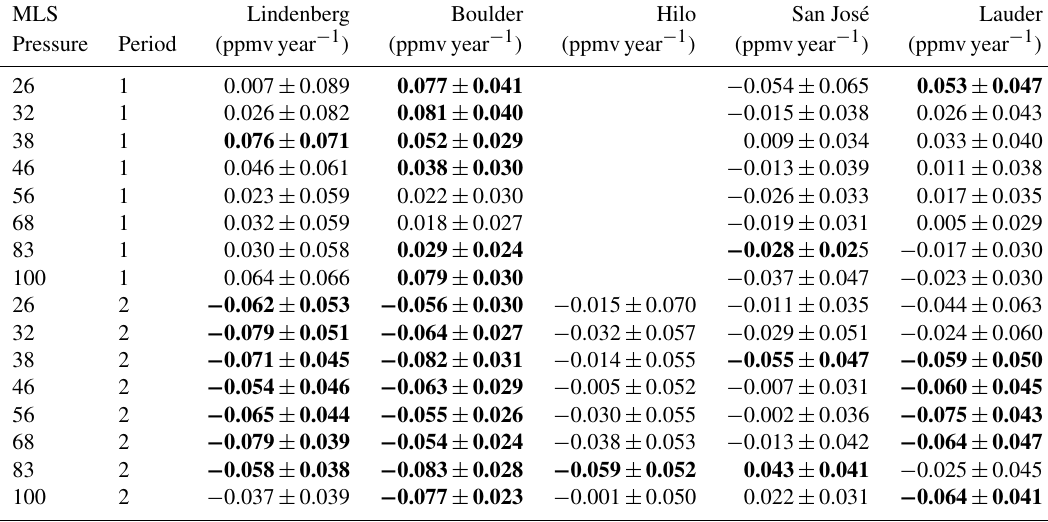
Table 5. Linear regression slopes of FP–MLS v4.2 differences. Slopes are presented with their 95% confidence intervals. Periods 1 and 2 refer to the intervals before and including the changepoint (Table 4) and immediately after the changepoint to 30 June 2015, respectively. Values in boldface type are statistically different from zero with 95% confidence.